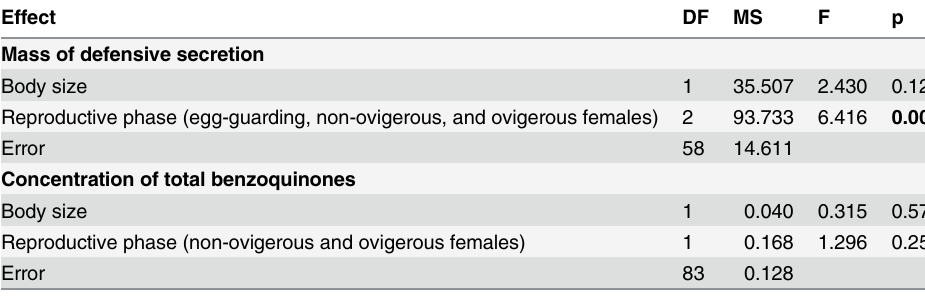
Table 1. Results of the GLM testing the effect of body size and reproductive phase on the mass of defensive gland secretion and concentration of total benzoquinones released by females of the har- vestman Acutisoma longipes . Significant p-values are shown in